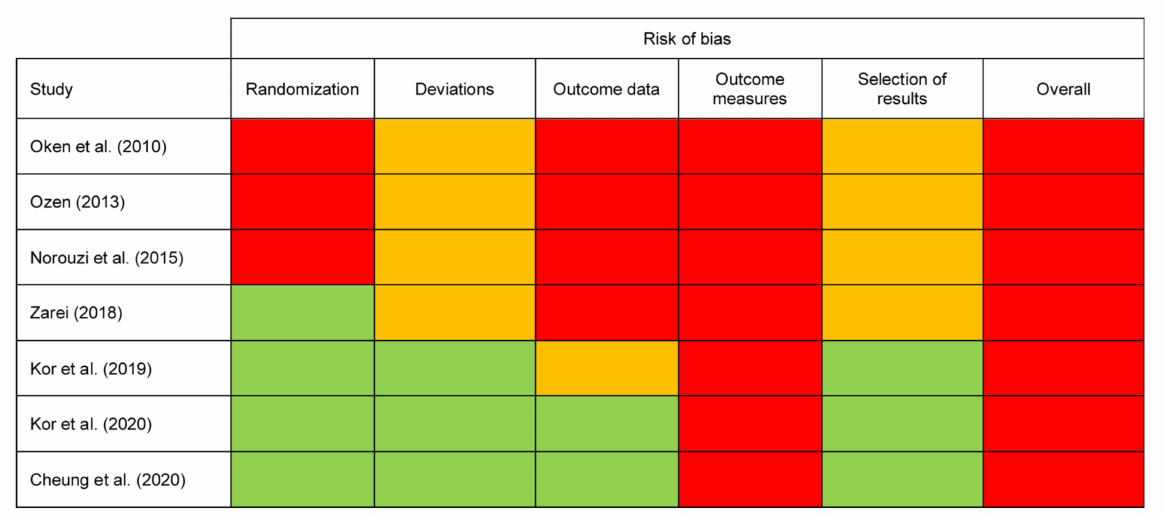
Figure 2. Risk of bias assessment. Note. Green = low risk, Amber = some concerns, Red = high